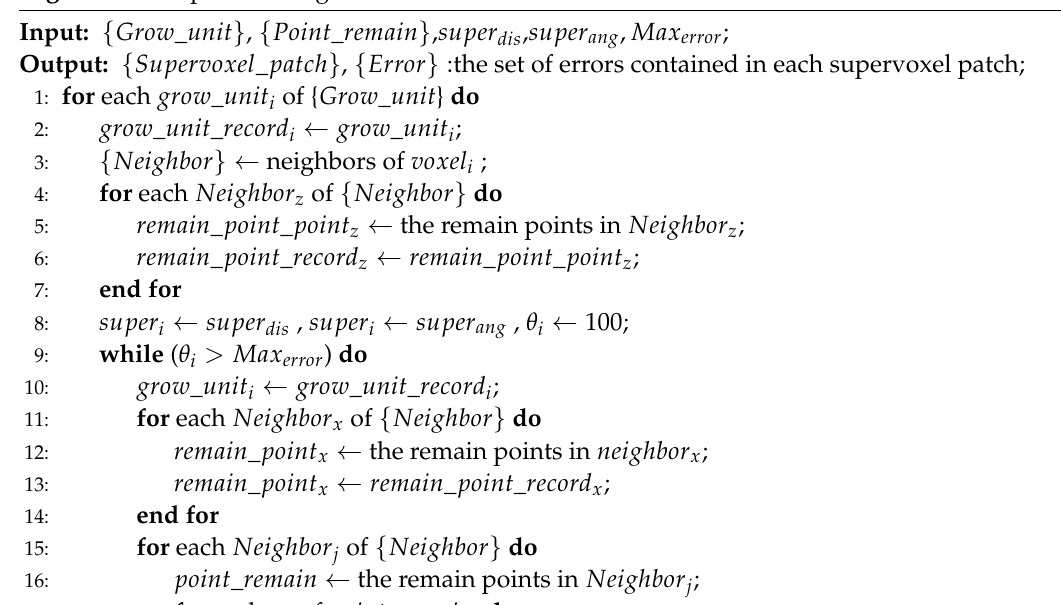
Algorithm 3 Supervoxel